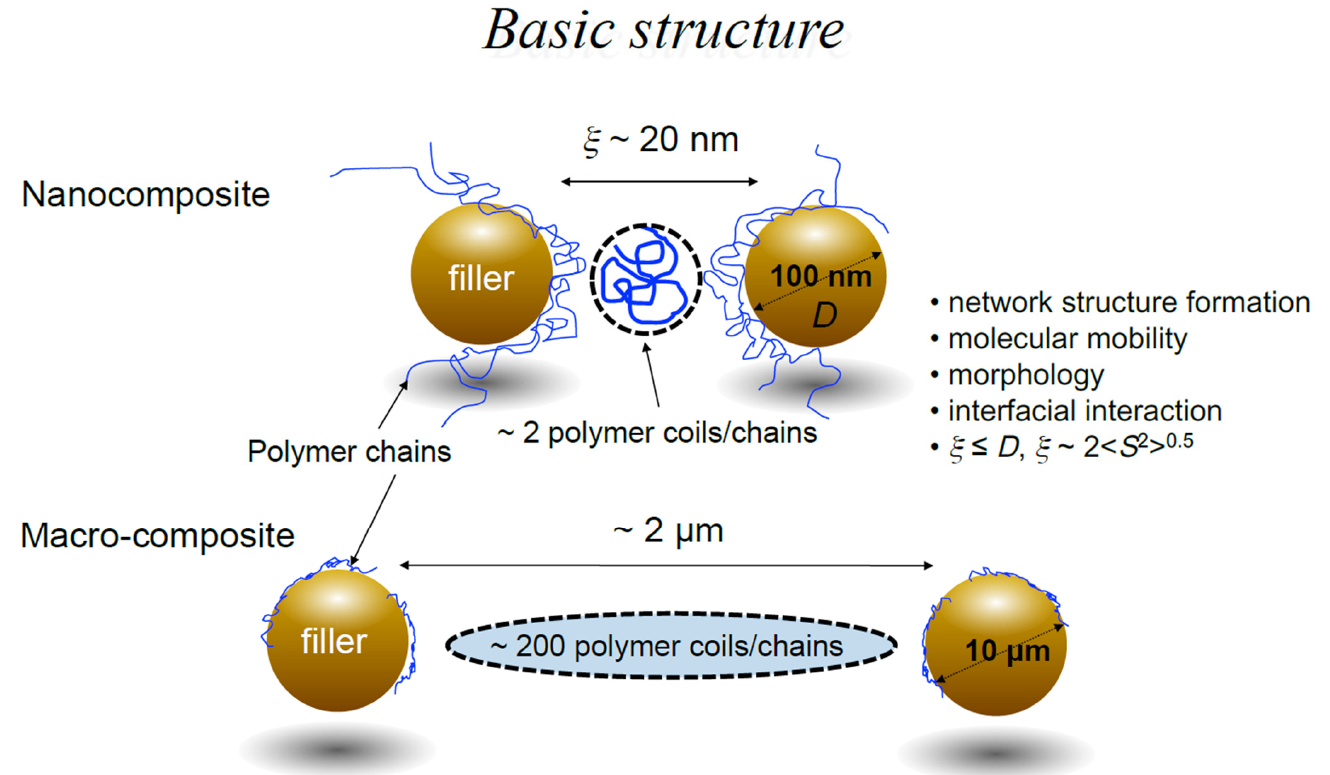
Figure 1. Typical particle reinforcements/geometries in nano- and macro-composites. The correlation length between filler particles ξ is smaller than average value of the particle diameter D ( ξ ≤ D ) with increasing filler content. In general, the ξ value ( ≅ 30 nm) corresponds to the random coil size of polymer. The root-mean-square radius of gyration < S 2 > 1/2 is around 10 nm, which is calculated by < S 2 > 1/2 = 4.0 × 10 − 2 M w1/2 [2]. The polymeric chain mobility presumably is decreased in translational motion. The morphological difference comes from the loading amount of filler